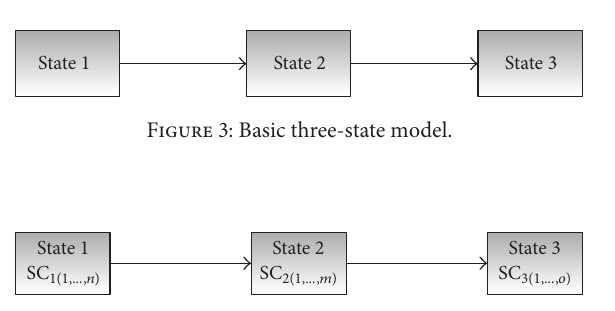
Figure 4: Basic three-state model with descriptive state characteris- tics (SCs).